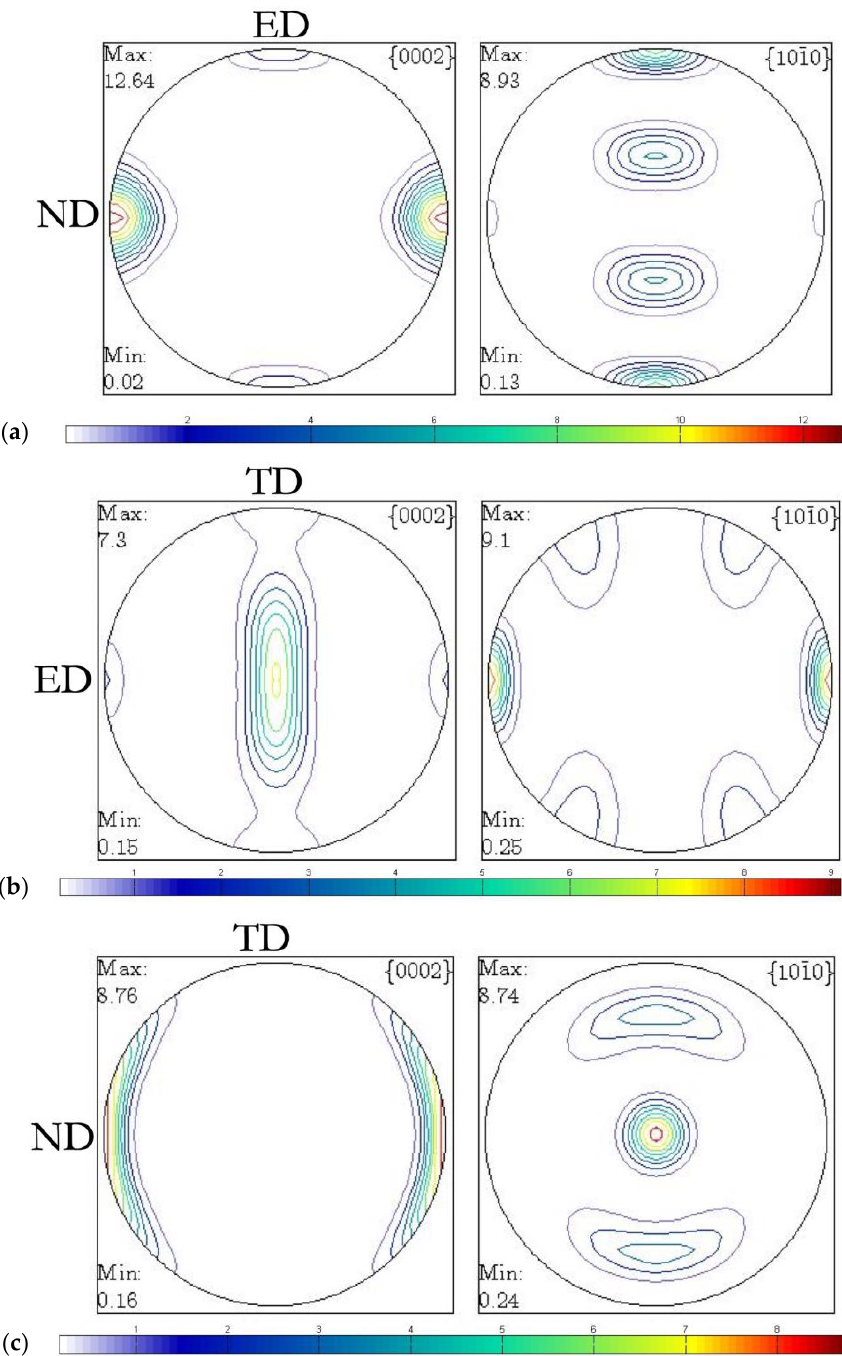
Figure 3. X-ray diffraction (XRD) pole figures of basal and prismatic reflections obtained on ( a ) ED-ND plane, ( b ) ED-TD plane, and ( c ) TD-ND plane of the starting extruded ZK60A-T5 magnesium alloy plate.